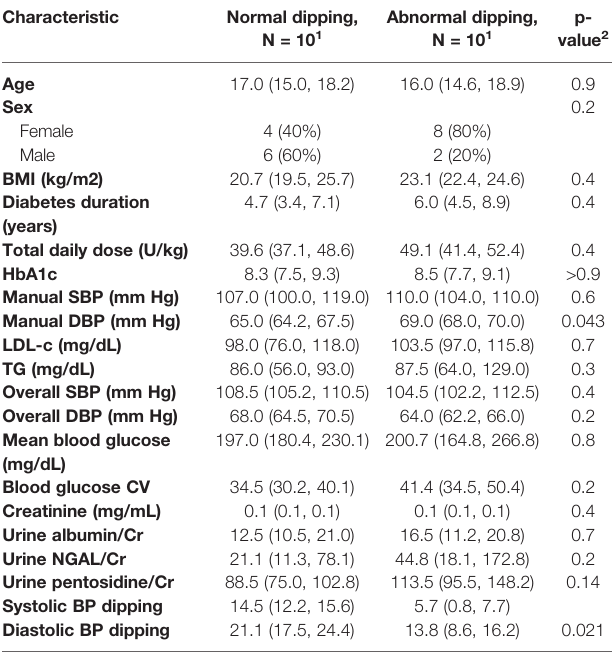
TABLE 4 | Baseline characteristics of the case groups with normal nocturnal dipping in systolic blood pressure and abnormal dipping. Characteristic